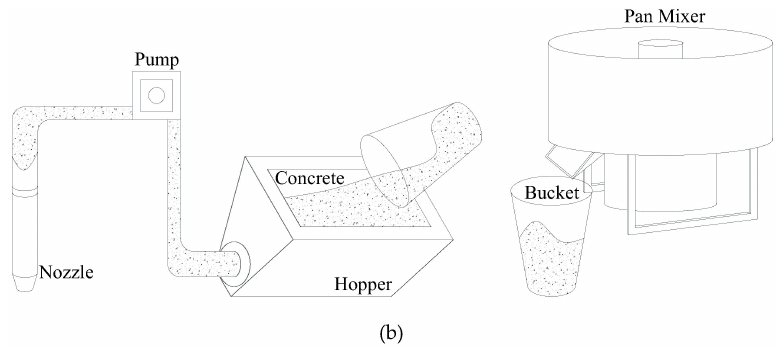
Figure 2. Classification of concrete supplying method. ( a ) Continuous supply; ( b ) Discontinuous supply.